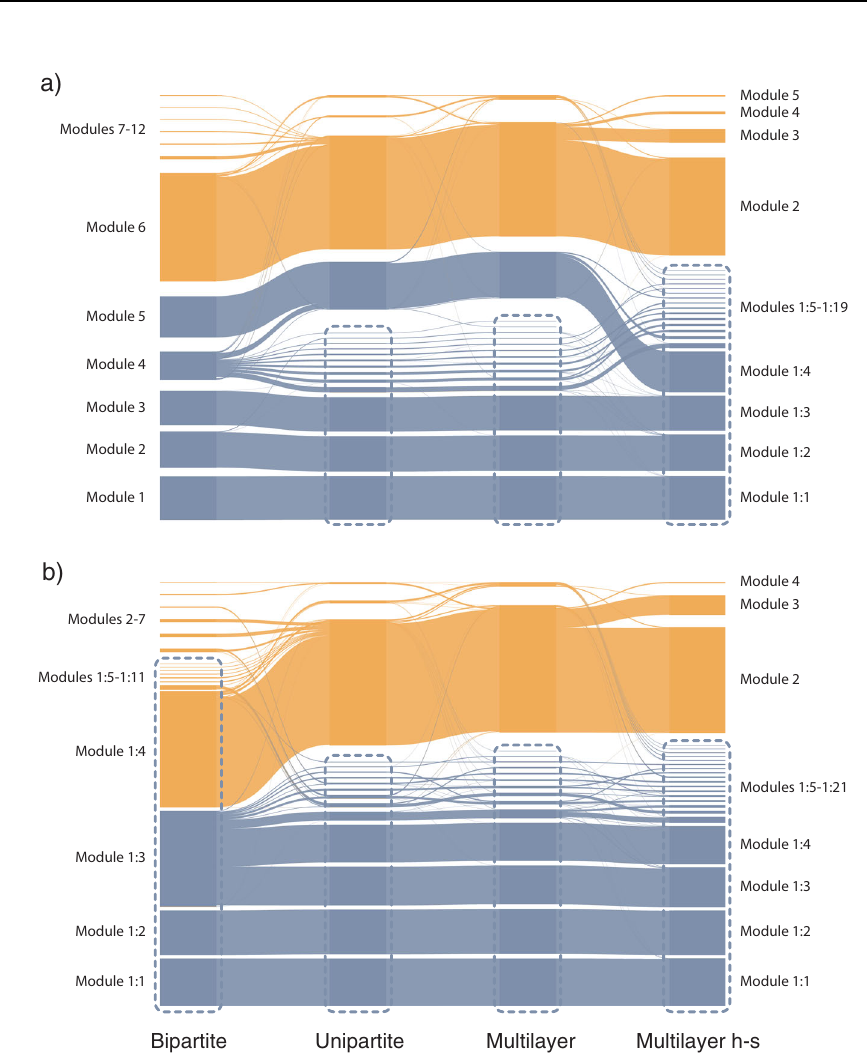
Fig. 7 Alluvial diagrams of optimised partitions for different representations of the C. elegans metabolic system. Modules that account for 99.9% of the fl ow volume are included. Darker bars represent the modules in each partition, with height proportional to the fl ow volume of the contained nodes. Streamlines connect modules that contain the same nodes. Lazy walks in a and non-lazy walks in b . Dashed lines surround the submodules that have the same parent module. Modules that appear together in the largest top module in the multilayer representations' partition coloured in blue. All other modules in orange. h-s